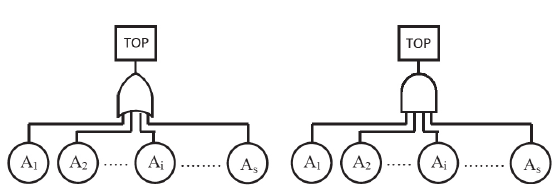
Fig. 4. FTA Left AND gate, right OR gate